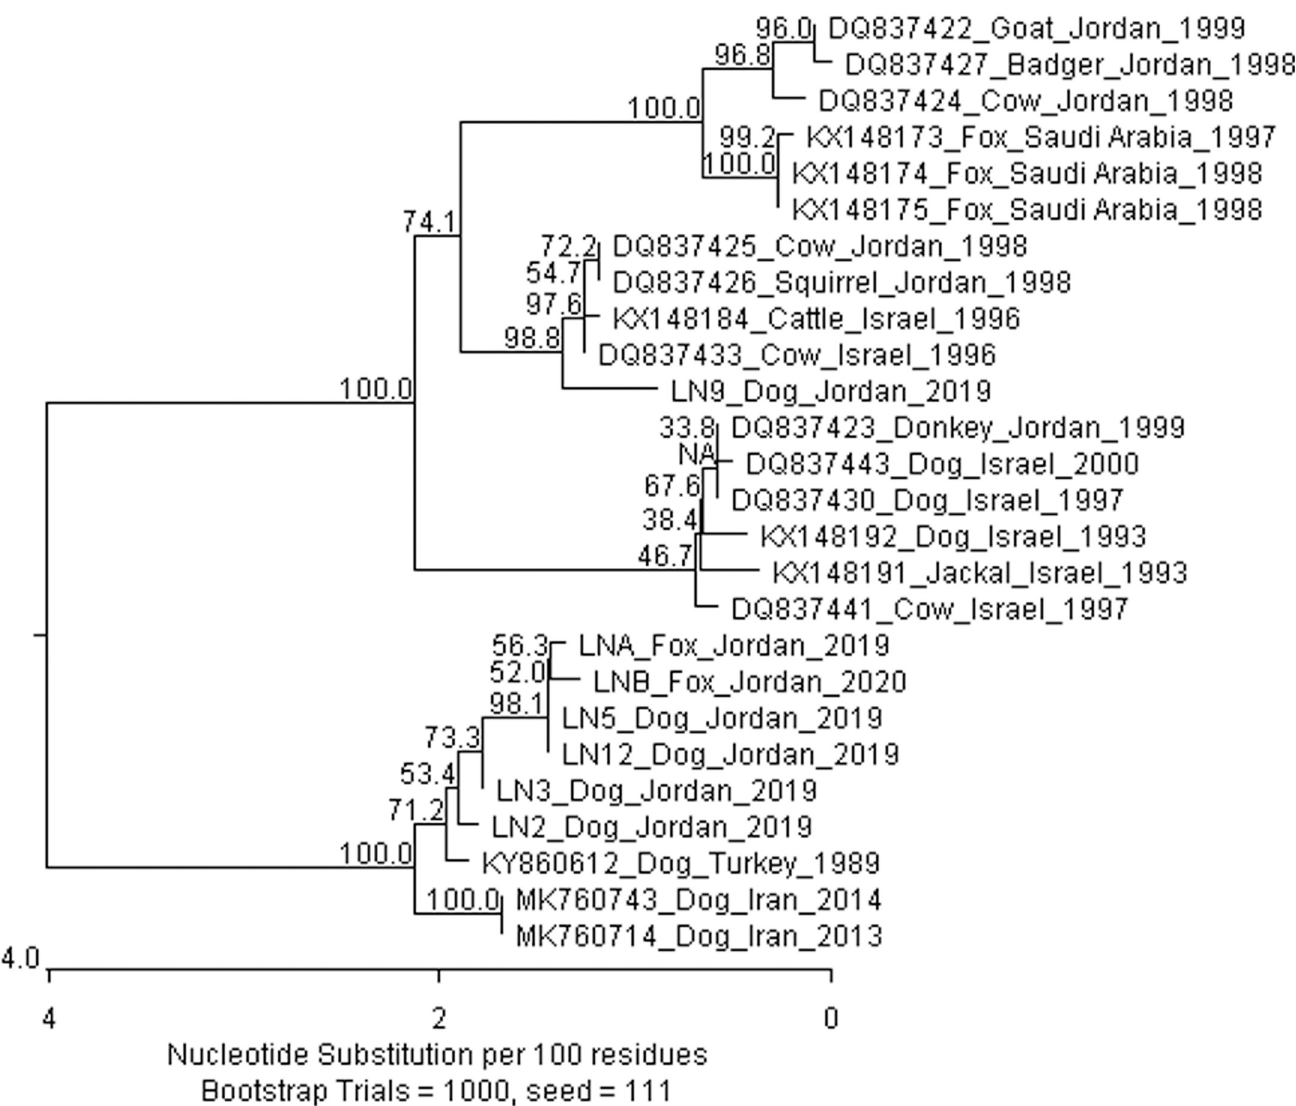
Fig 3. Phylogenetic tree generated by ClustalW (MegAlign, DNASTAR Version 15.0.0) using the sequences of the N genes from this study and those found from nearby